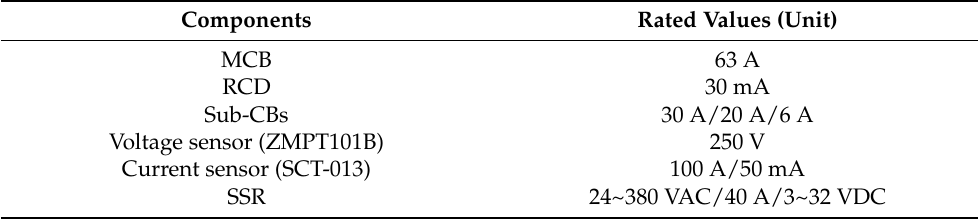
Table 1. Power components used in DPB